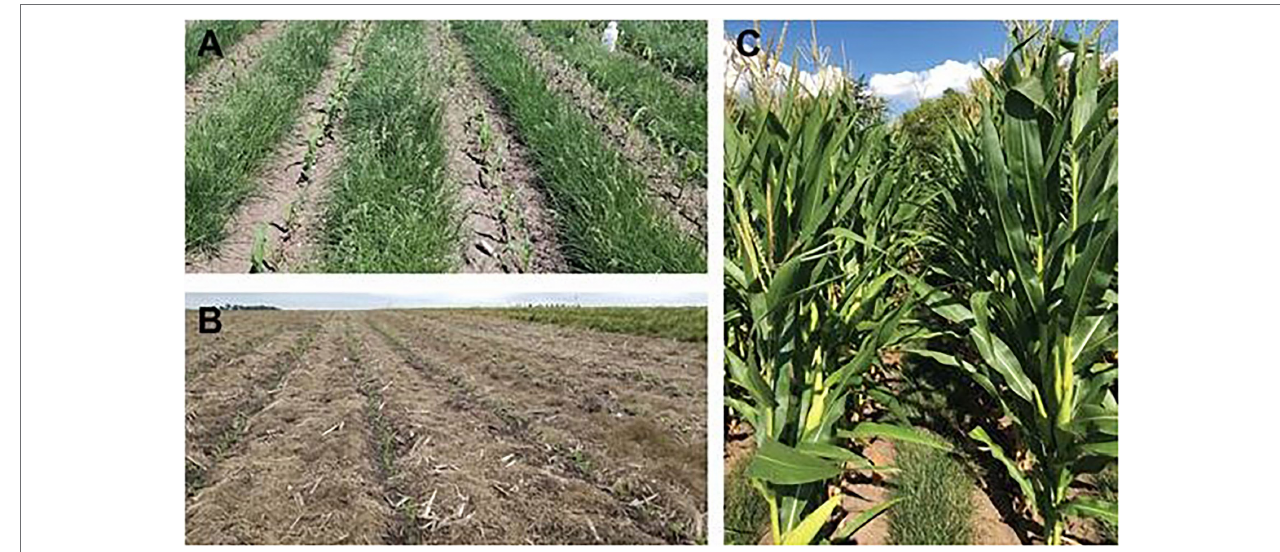
FIGURE 4 | Examples of maize intercropped with turfgrass perennial groundcovers (PGC). (A) Maize intercropped with strip-tilled but not chemically suppressed Kentucky bluegrass PGC. (B) Maize intercropped with a creeping red fescue PGC that has been chemically suppressed. Chemical suppression reduces the likelihood that the maize undergoes a shade avoidance response (SAR), which results in yield loss. (C) Maize intercropped with Kentucky bluegrass on August 2, 2020 in Ames, IA, United